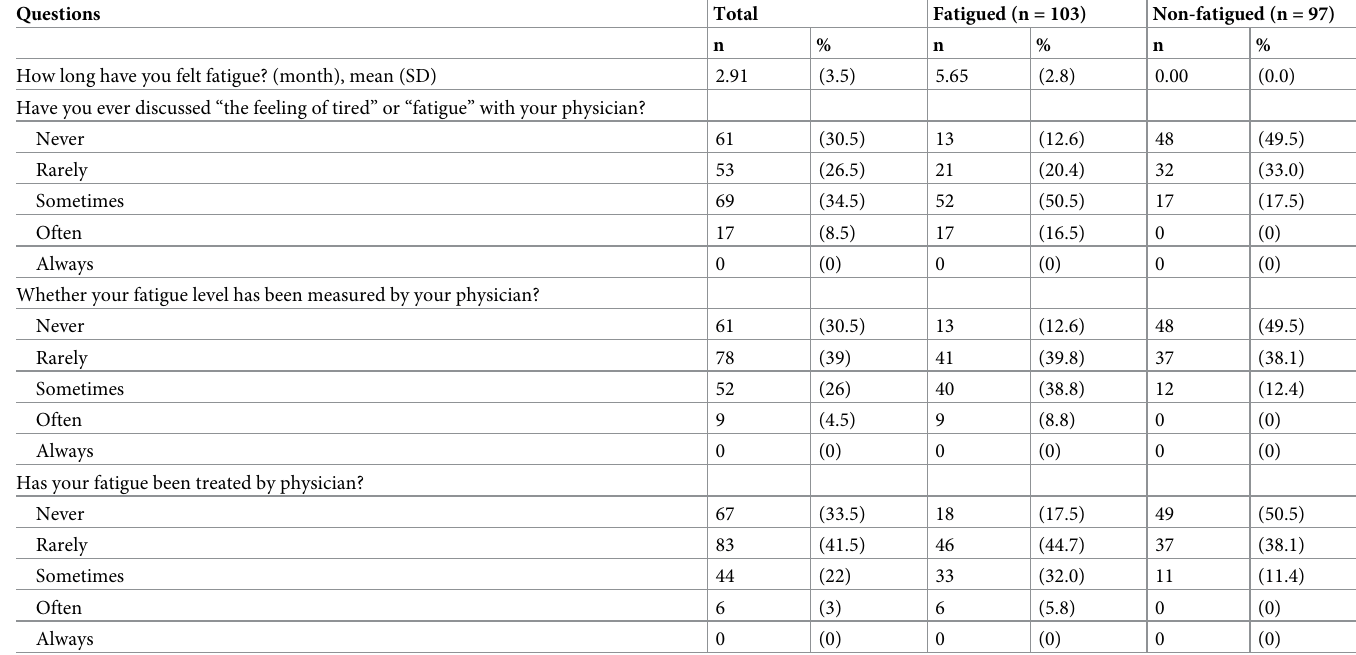
Table 2. Healthcare utilization of fatigue among patient with type 2 diabetes (n =